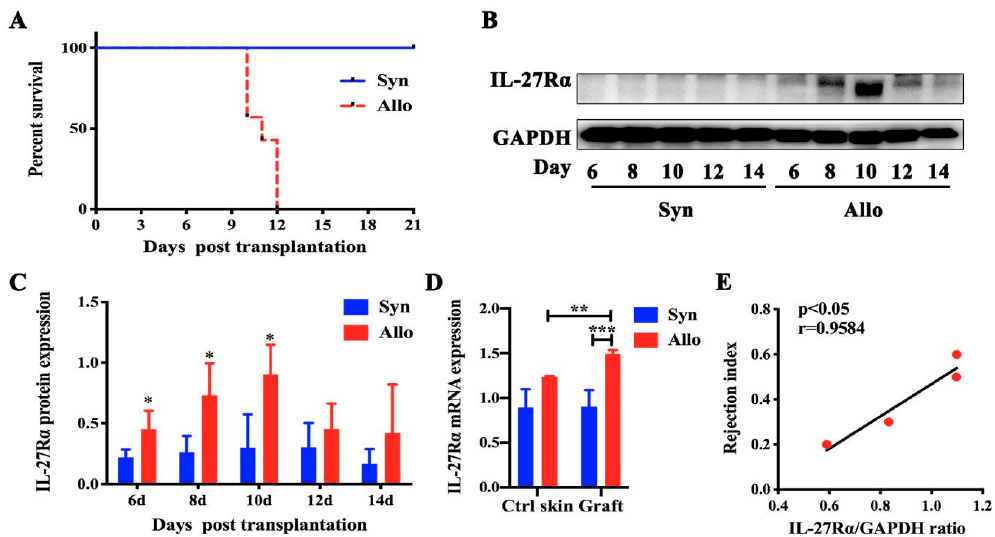
Figure 1. Dynamic IL-27R α expression in allogeneic grafts post transplantation. Skin transplantation mice models were established and grafts were isolated on day 6, 8, 10, 12, and 14 post transplantation.